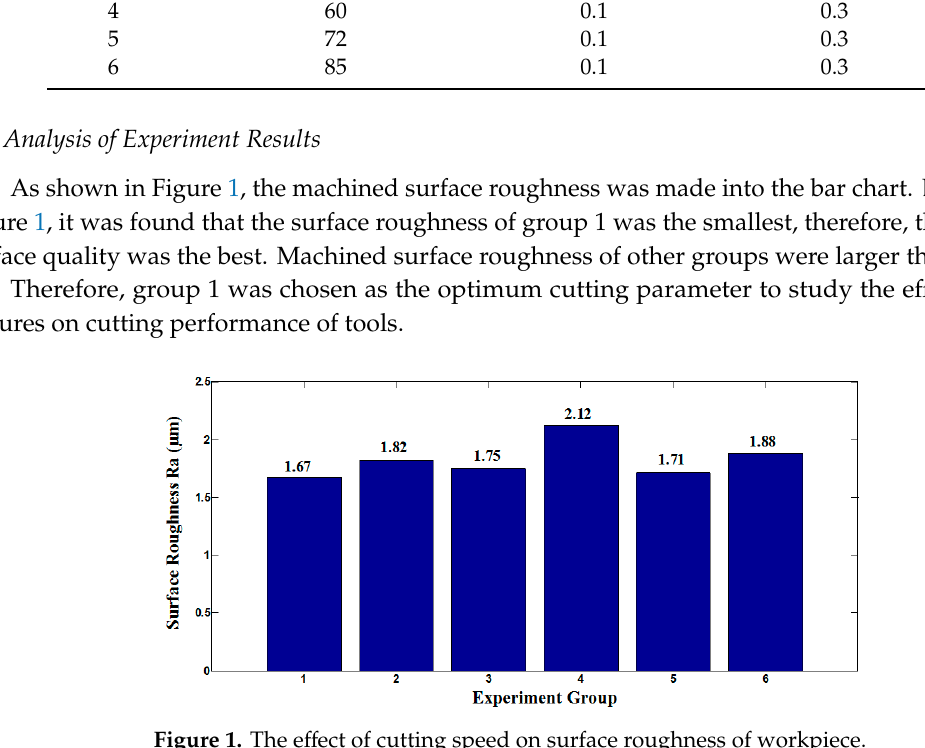
Figure 1. The e ff ect of cutting speed on surface roughness of Figure 1. The effect of cutting speed on surface roughness of workpiece.